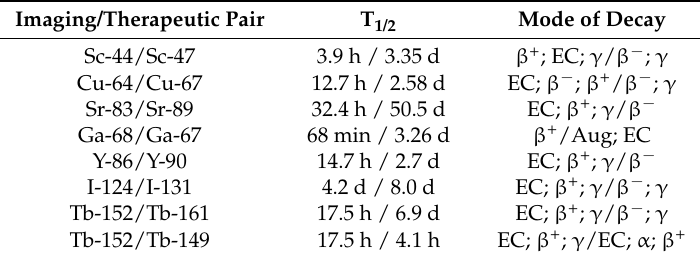
Table 3. Theranostic radioisotopes pair [31].